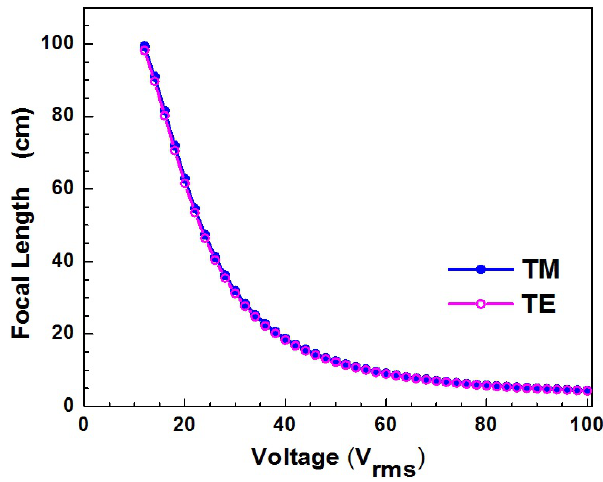
Figure 13. Simulated focal lengths of a PS-BPLC microlens at different voltages.